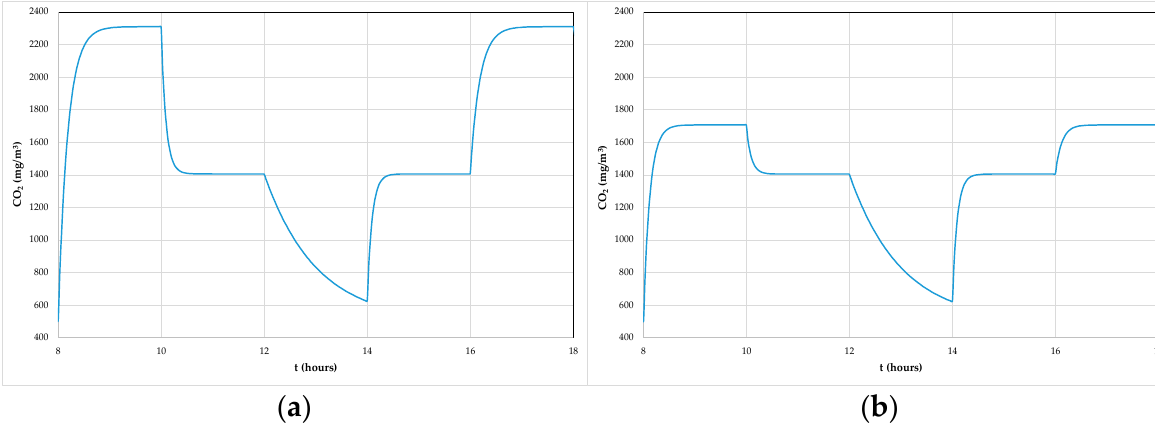
2 ) concentration, for Case I ( a ) and Case J ( b ).